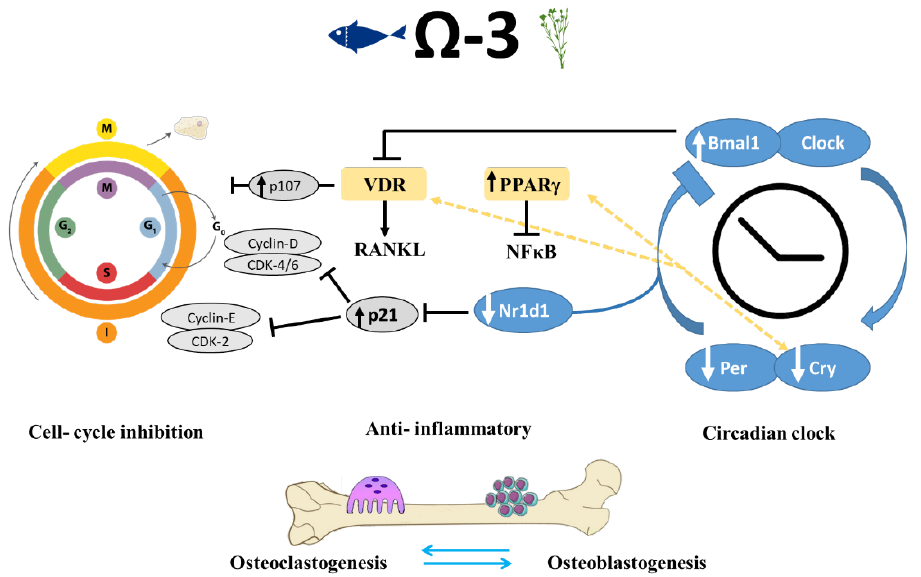
Figure 7. Schematic view of mechanisms implicated in the regulation of bone-formation process by circadian clock and cell-cycle genes in mice that were fed n-3 PUFAs. Shown are the pathways identified in this and previous studies, suggesting that n-3 PUFAs are linked to bone remodeling at multiple levels via peripheral circadian clock and cell-cycle genes, as well as through their anti-inflammatory activity. VDR-vitamin D receptor, RANKL-Receptor activator of nuclear factor kappa-B ligand, PPAR-peroxisome proliferator-activated receptor, NFKB- nuclear factor